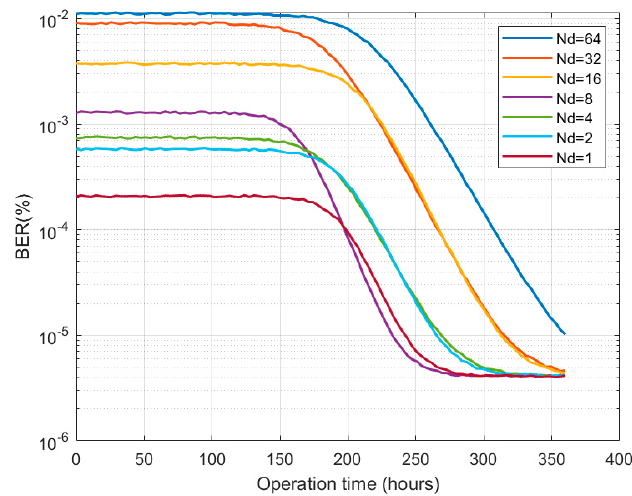
Figure 10. Results from the second experiment.